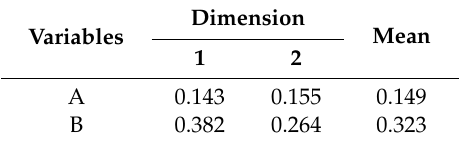
Table A7. Discrimination measures of the variables in each